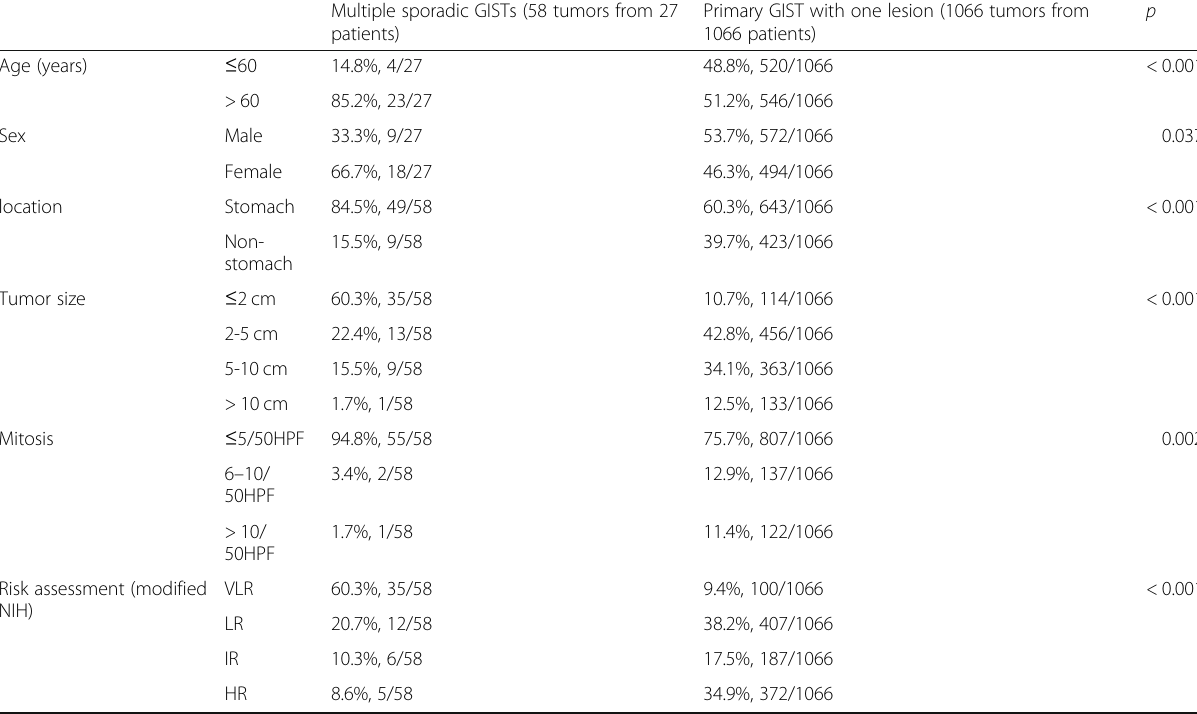
Table 3 Comparison of clinicopathological features between multiple sporadic GISTs and primary GISTs with only one lesion Multiple sporadic GISTs (58 tumors from 27 Primary GIST with one lesion (1066 tumors from patients) 1066